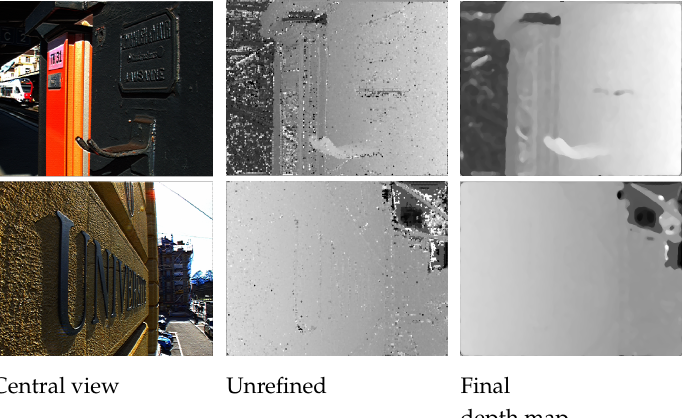
Figure 13. Comparison between the estimated depth map before and after the refinement step for real